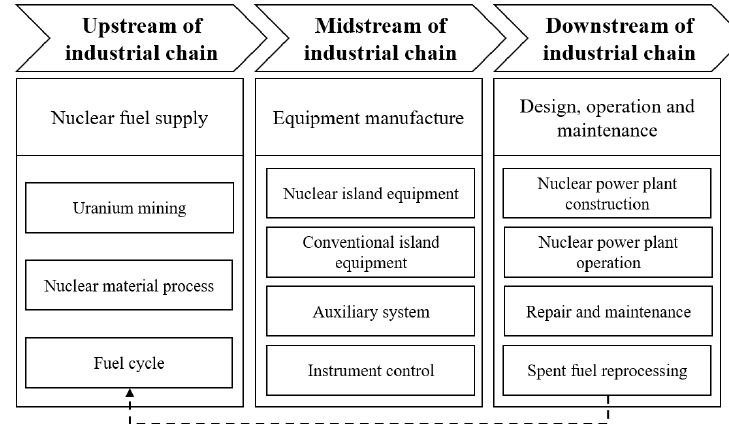
Fig. 2 Nuclear power industry chain with upstream, midstream, and downstream segments. Among them, the upstream segment is mainly nuclear fuel supply, the midstream is nuclear equipment manufacturing, and the downstream is nuclear power plant design, operation, and